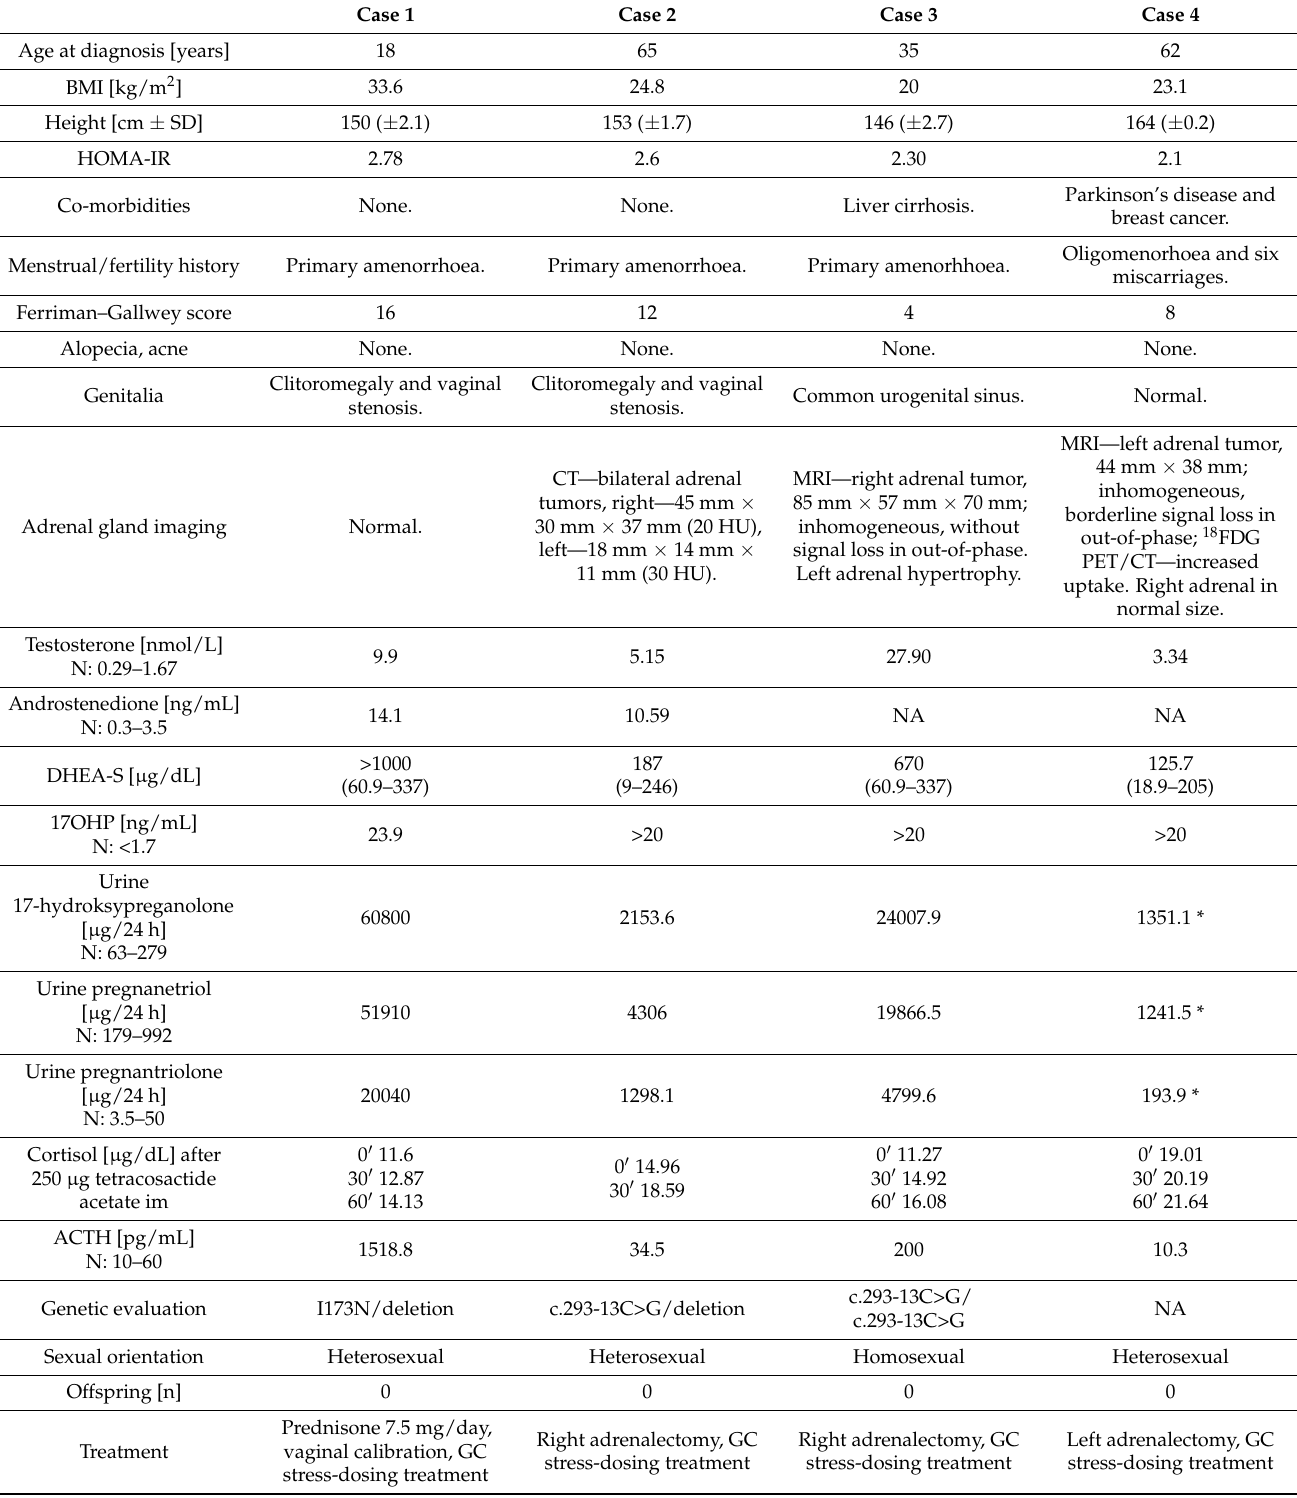
Table 1. Characteristics of female patients with congenital adrenal